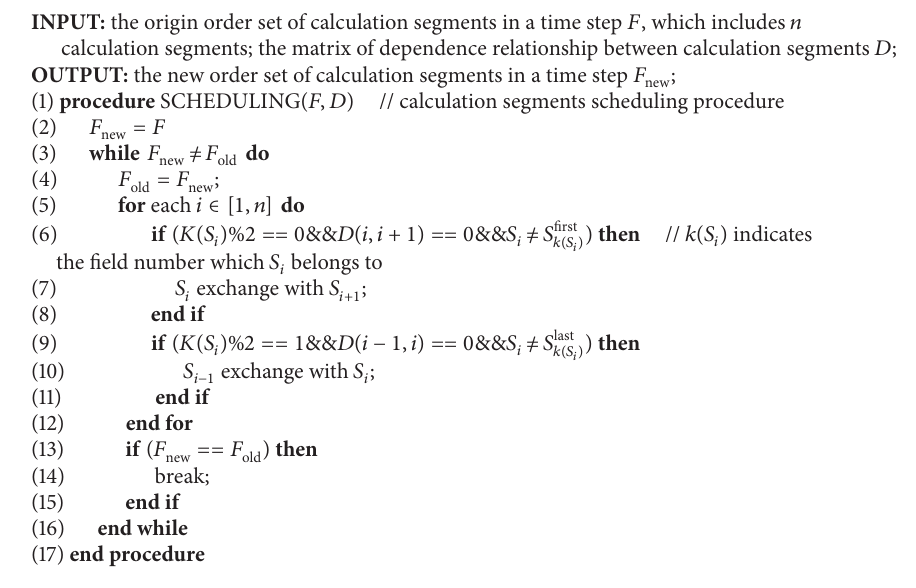
Compute process